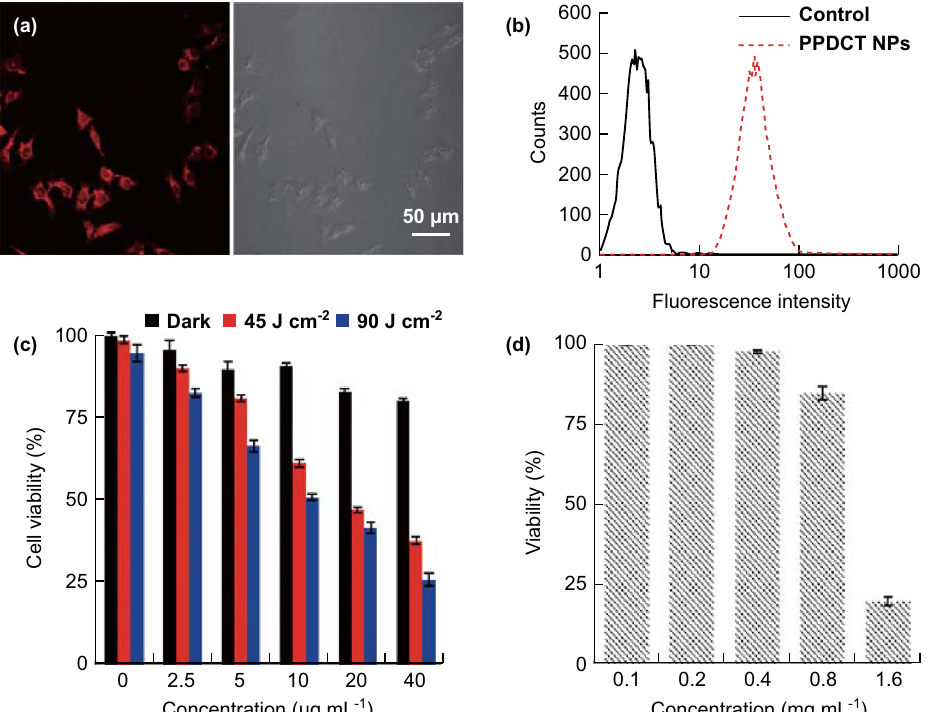
Fig. 2 a Confocal image of HepG2 cells incubated with PPDCT NPs. b Cellular internalization of PPDCT NPs confirmed using flow cytometry. c MTT viability assay of HepG2 cells treated with PPDCT NPs and 0.15 W cm - 2 white light (WL 0, 45 and 90 J cm - 2 ). d Whole zebrafish embryo soaking viability for treatment with different PPDCT NP